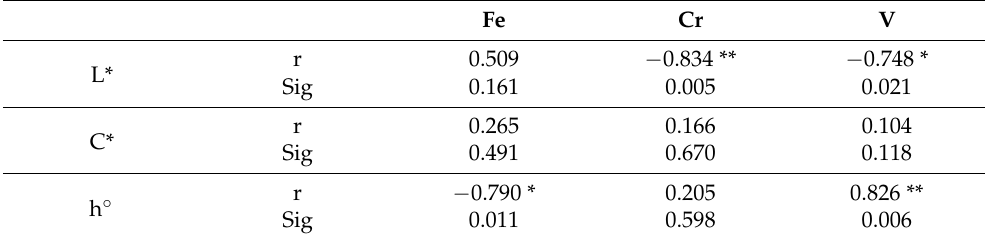
Table 6. Bivariate correlation analysis between spinel composition and color parameters. ** At level 0.01 (double tail), the correlation was significant. * At level 0.05 (double tail), the correlation was